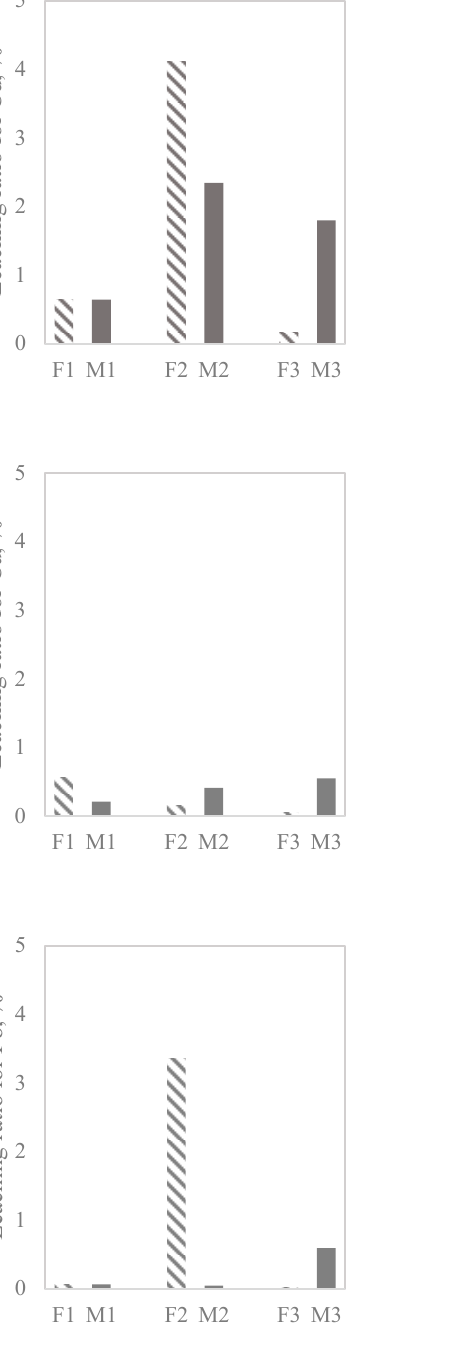
Figure 1. Ratio of leached metal in the crushed cement composite compared to the primary samples (WBA eluates F1, F2, and F3).